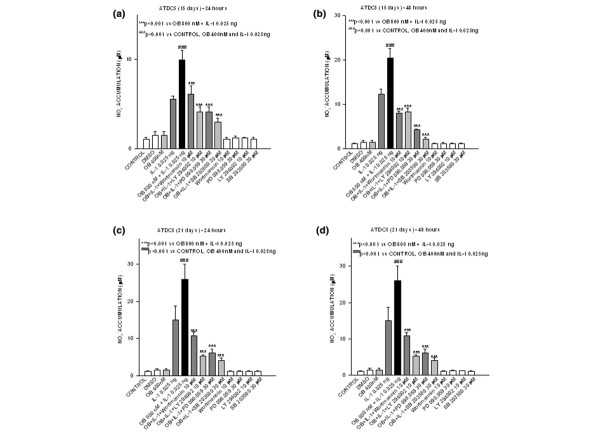
Leptin synergism does not depend upon chondrocyte differation state. Effect of different inhibitors on nitrite (NO2-) accumulation in 15-day differentiated ATDC5 cells stimulated or not with leptin, alone or in combination with IL-1, during (a) 24 and (b) 48 hours. The effect of inhibitors was also evaluated in 21-day differentiated ATDC5 cells, after (c) 24 or (d) 48 hours of stimulation with leptin and IL-1 (alone or in combination). Values are expressed as mean ± standard error of the mean. OB, leptin.